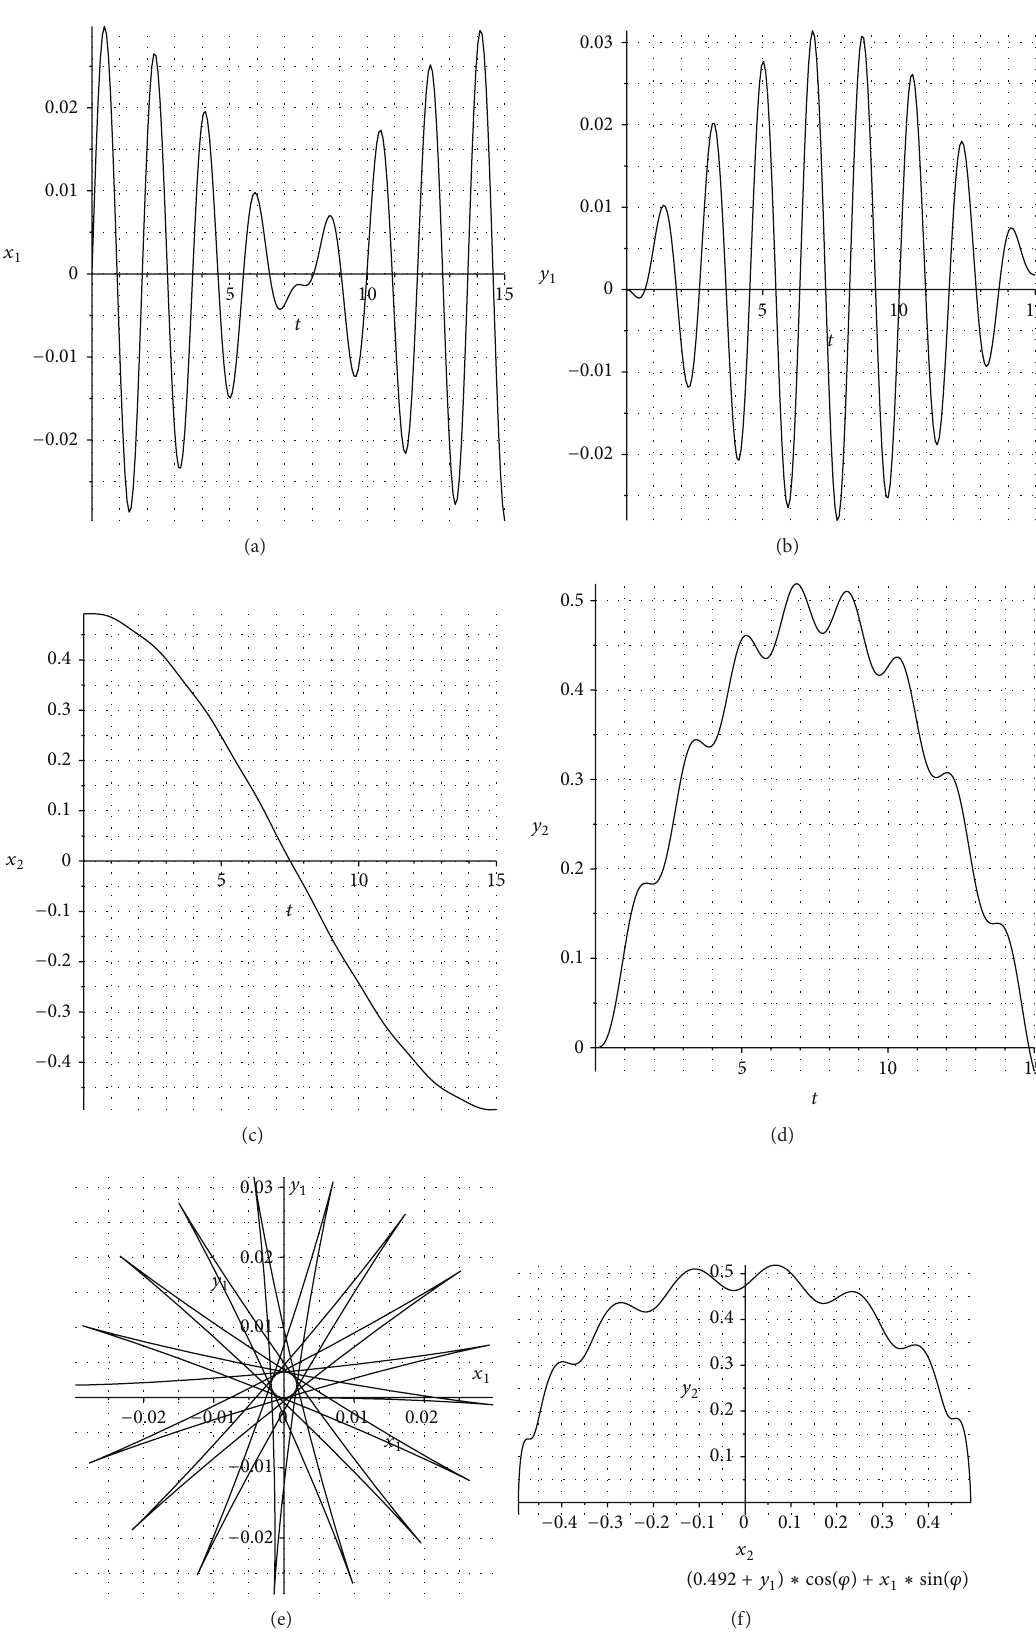
Figure 1: Computational relative (a-b, e) and computational absolute (c-d, f) coordinates of a swaying payload during uniform crane boom slewing for the following numerical values of system parameters: 𝑚 = 0.1 kg; 𝑙 = 0.825 m; 𝑅 = 0.492 m; 𝑔 = 9.81 m/s 2 ; and 𝜔 𝑒 = 0.209